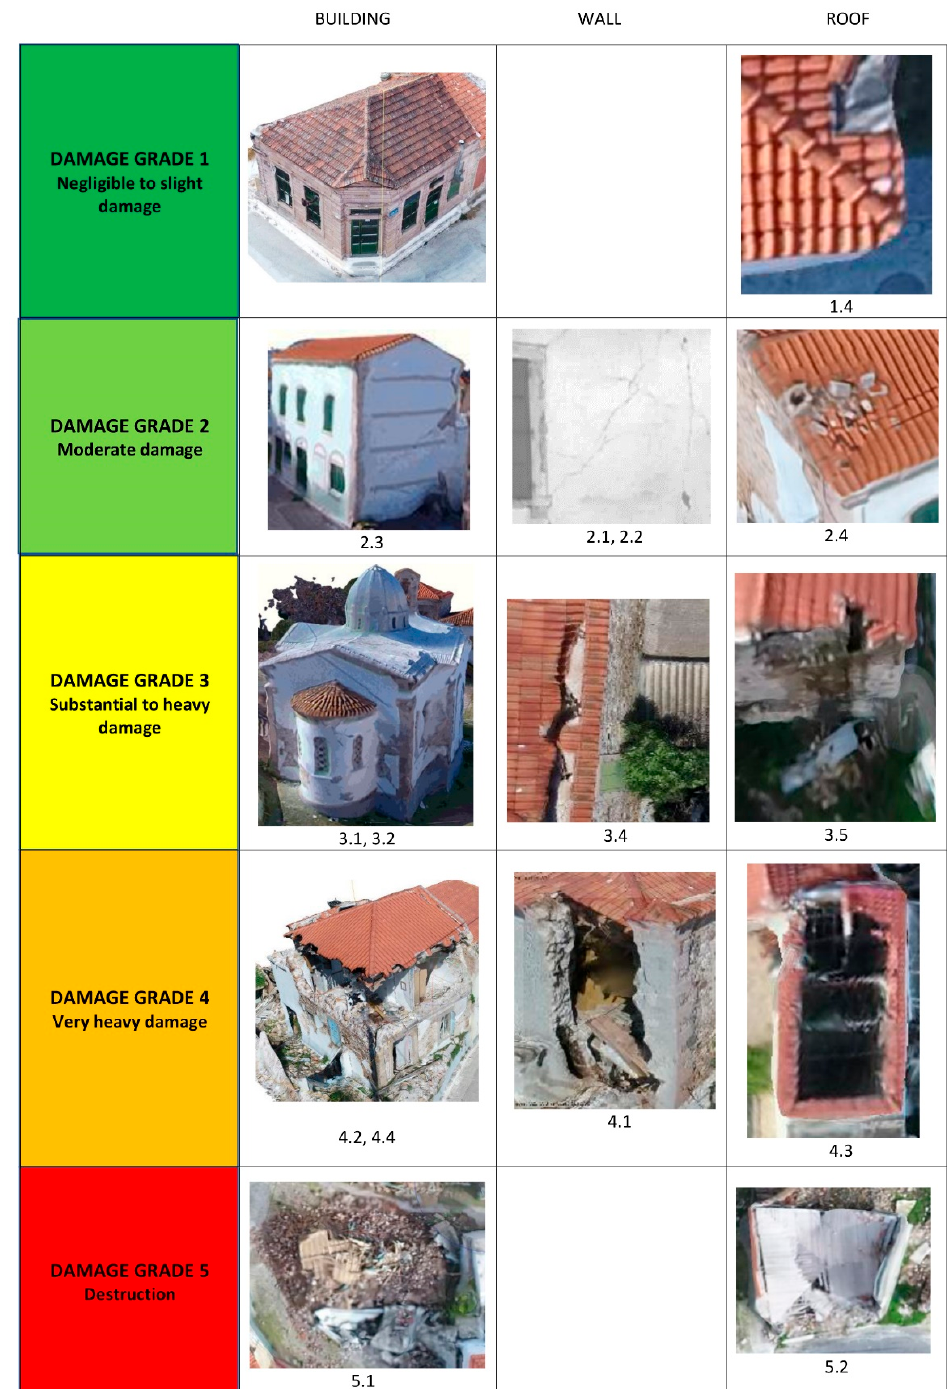
Figure 6. Categorization of seismic damage at the level of buildings, walls and roofs according to EMS-98 as shown in several 3D models created by processing UAS images. The subcategories of these grades on the walls: 2.1 Cracks in many walls, 3.1 Large and extensive cracks in most walls, 3.2 Diagonal large and extensive cracks in most walls, 3.3 Failure of individual non-structural elements (partitions, gable walls), 4.1 Serious failure of walls and 5.1 Total collapse. The subcategories of these on the roofs are: 1.4 Fall of roof tiles, 2.4 Partial collapse of chimneys, 3.4 Roof tiles detach, 4.3 Partial structural failure of roofs and 5.1 Total collapse.